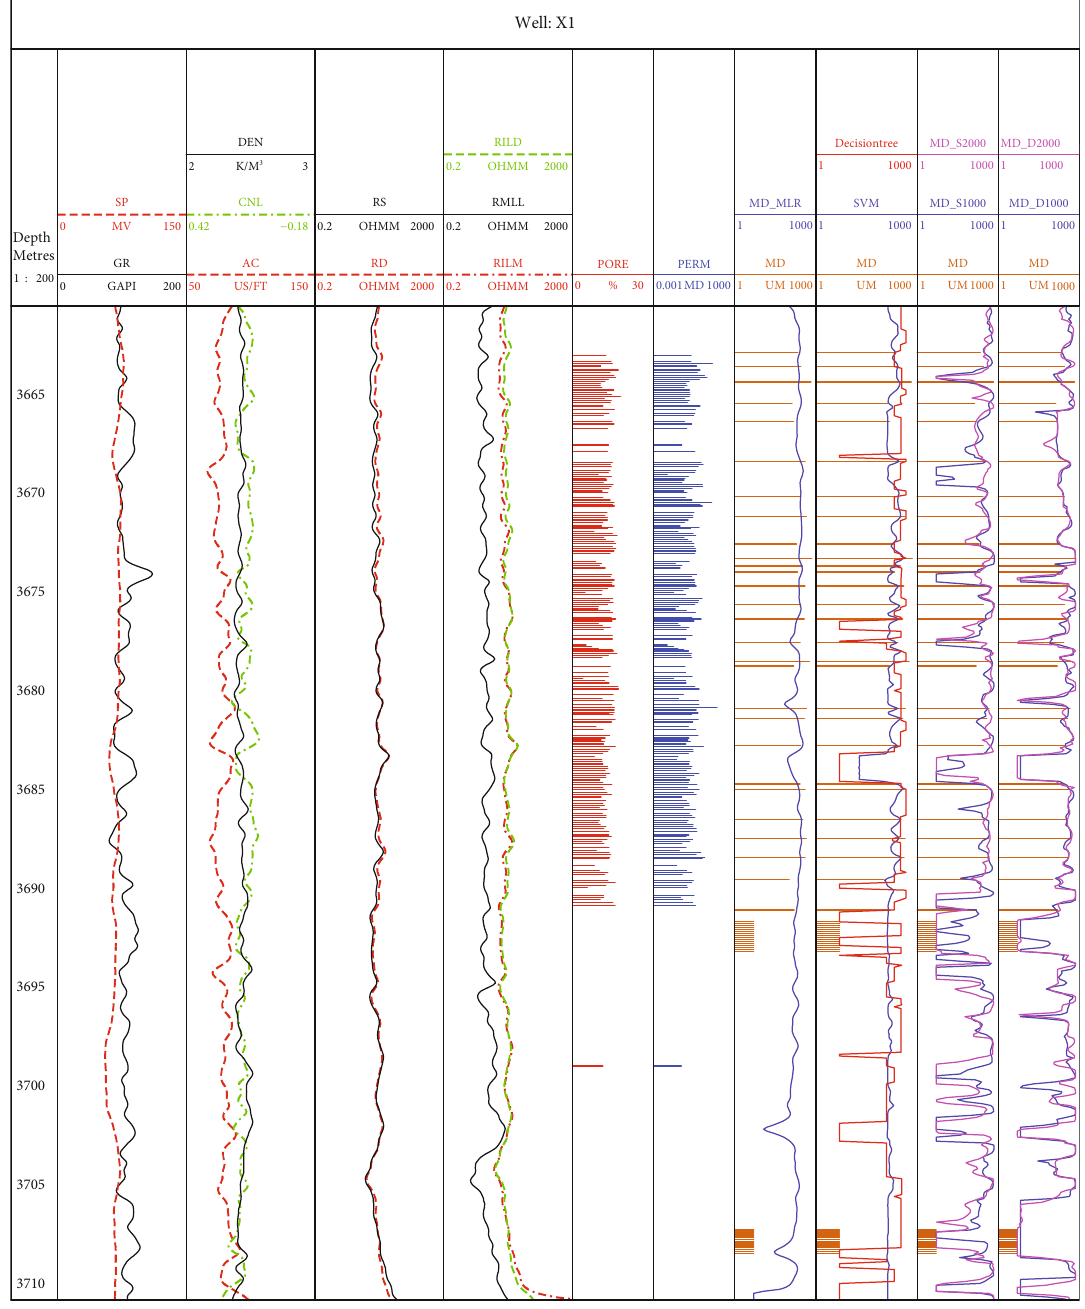
Figure 14: The results of the prediction of the median rock grain size of the conventional logging data in the S